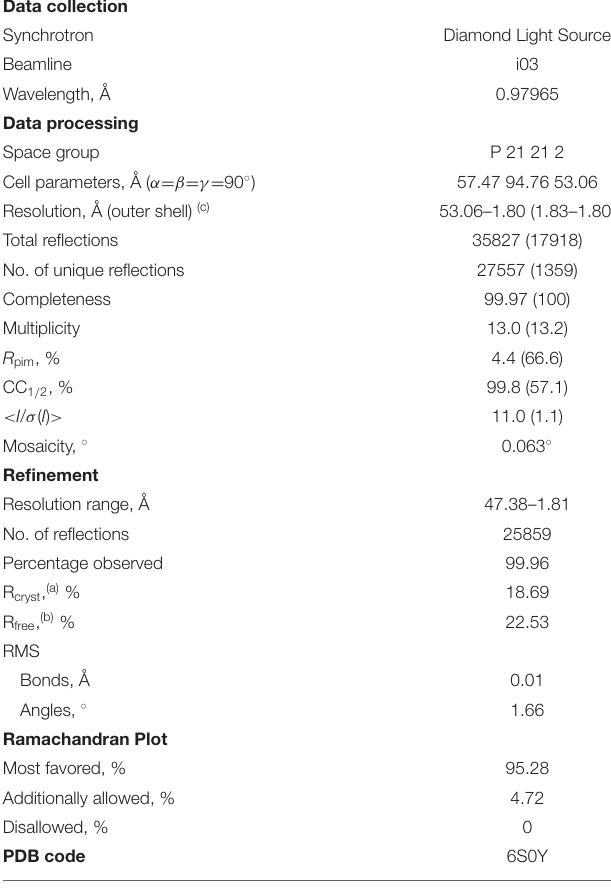
TABLE 1 | Data collection statistics and refinement